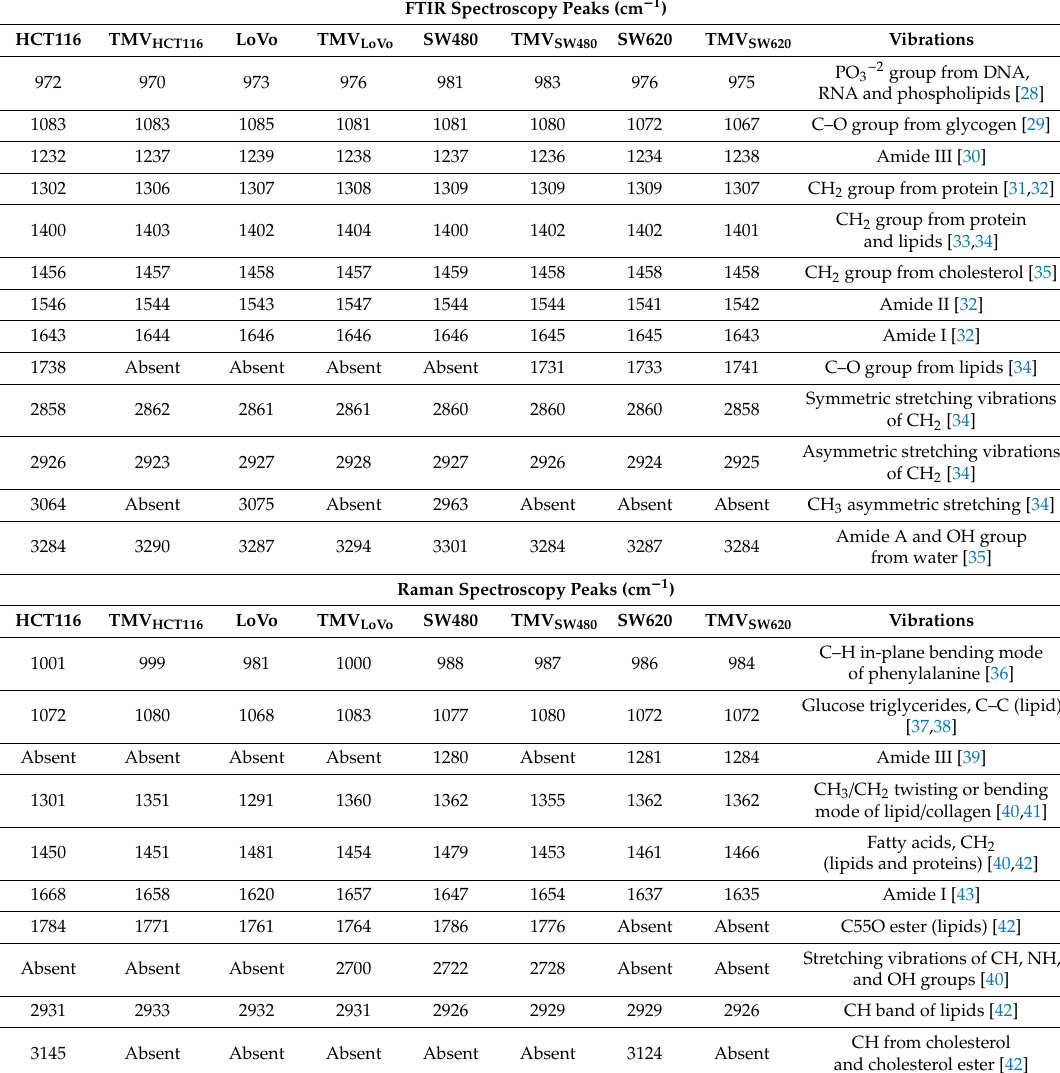
Table 1. The Fourier Transform InfraRed (FTIR) and Raman peak positions in the analyzed cell line and TMV samples with a description of the vibrations corresponding to the respective functional groups